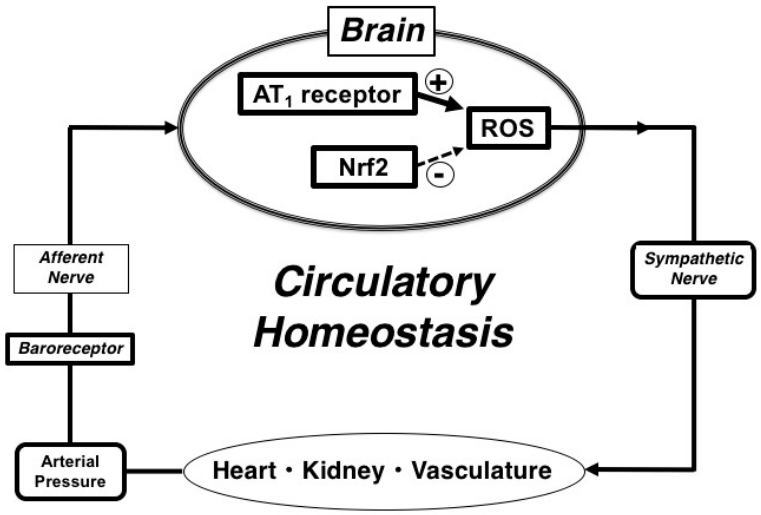
Figure 8. The schema of the concept demonstrated in the present study. + arrow; activation, – dashed arrow; inhibition, AT 1 ; angiotensin II type 1, ROS; reactive oxygen species, Nrf2; nuclear factor erythroid 2-related factor 2.